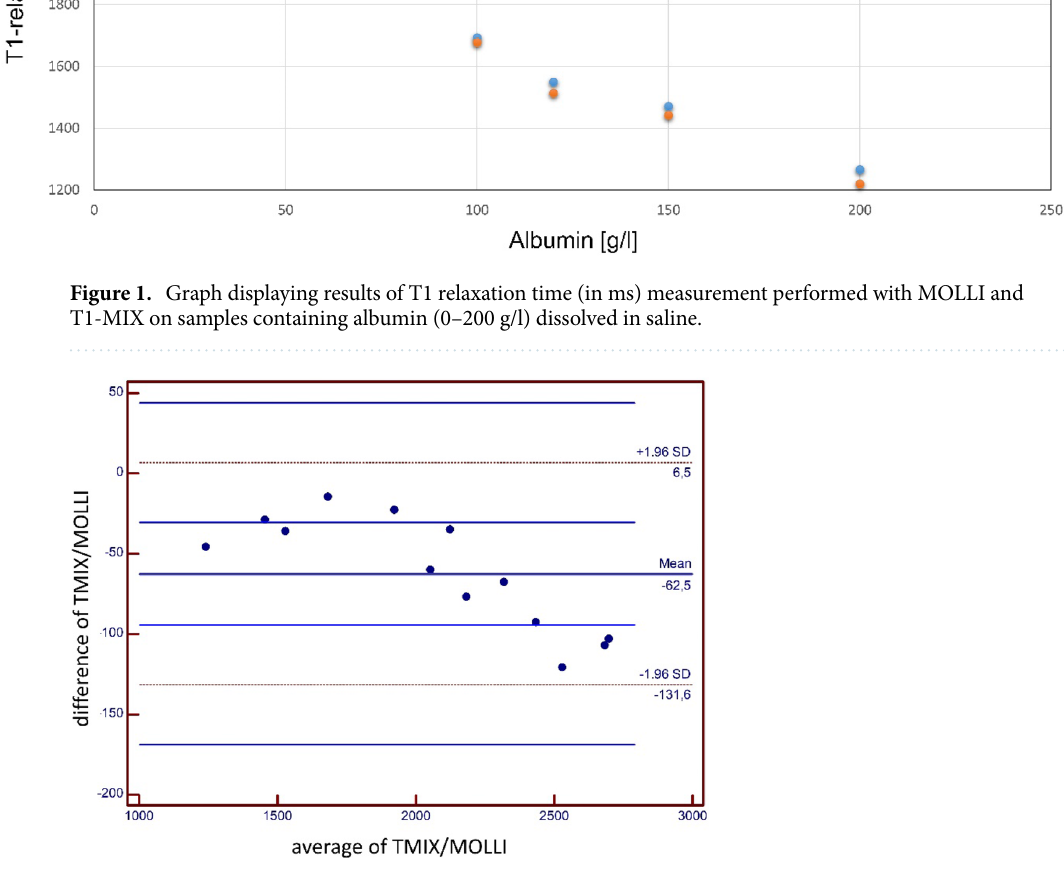
Figure 2. Bland–Altman plot for agreement between T1 measurements of TMIX and MOLLI for phantom analysis. Blue lines indicate 95% limits of agreement. SD = standard